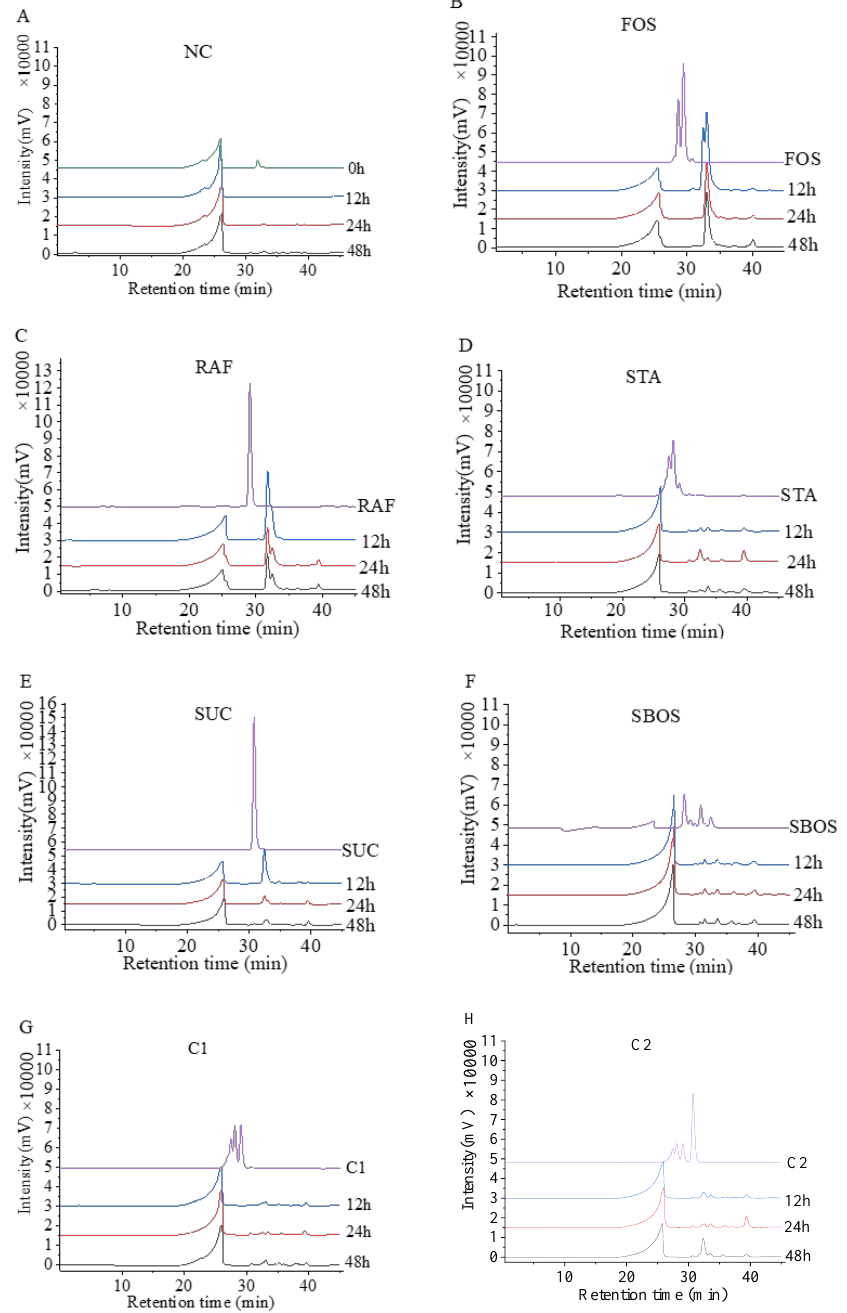
Figure 4. Mw distribution of NC ( A ) and oligosaccharides FOS ( B ), raffinose (RAF) ( C ), stachyose (STA) ( D ), sucrose (SUC) ( E ), SBOS ( F ), C1 ( G ), C2 ( H ) before and after simulated intestinal fermentation by human fecal microbiota.